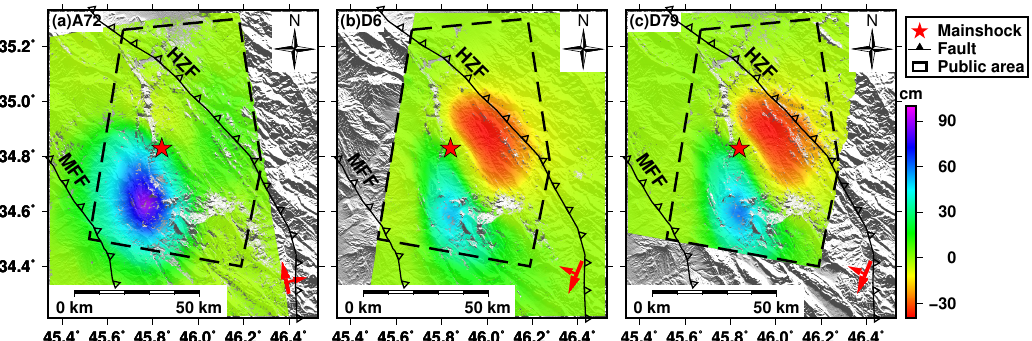
Figure 3. Co-seismic interferograms from the ascending and descending tracks. ( a ) A72, ( b ) D6, and ( c ) D79. Black lines are faults. The dotted polygon indicates the common area of the ascending and descending tracks. Red stars represent the